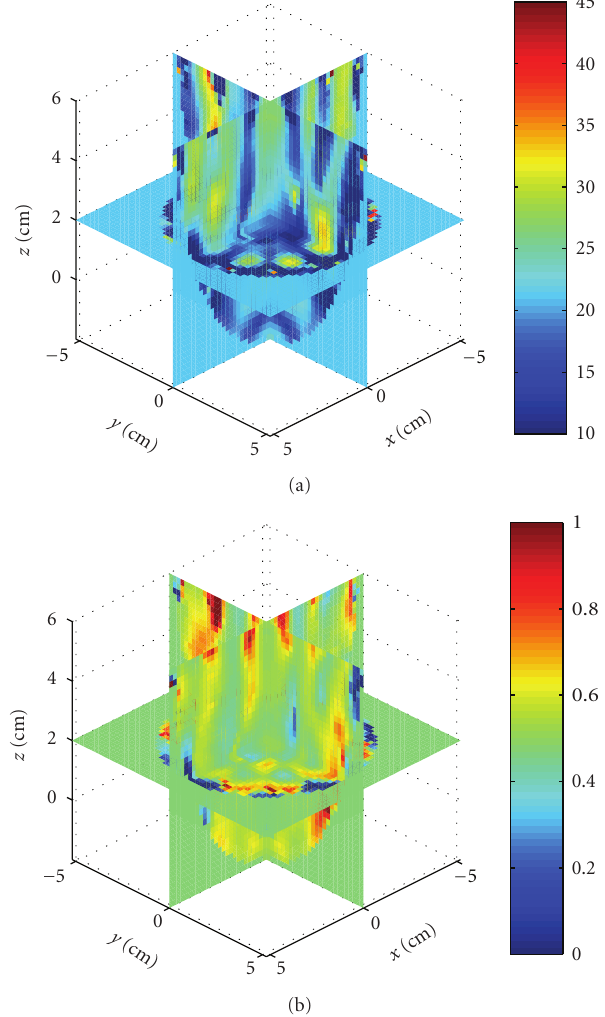
Figure 17: Reconstructions of the HFSS numerical breast phantom, which includes the chest wall of Example 3. (a) and (b) Relative permittivity and conductivity, respectively. The object could not be